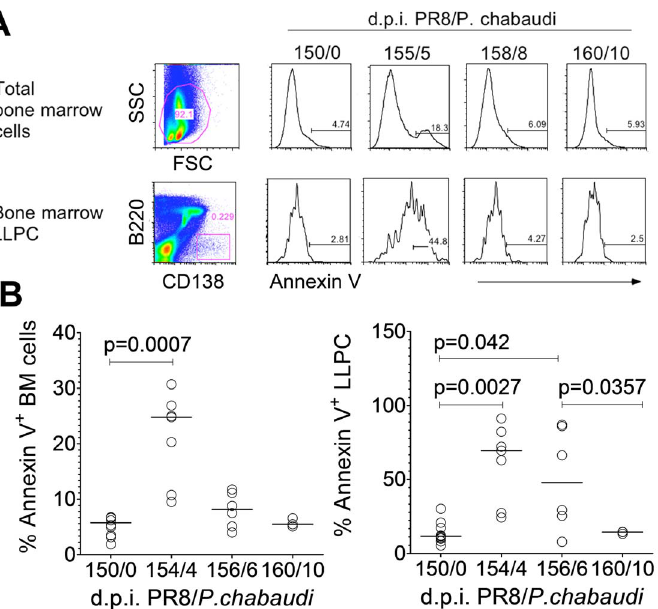
Figure 3. Long-lived plasma cells undergo apoptosis during acute P.chabaudi infection. A. Representative flow cytometry plots of total bone marrow cells and bone marrow LLPCs; and relative expression of Annexin V on days 0, 5, 8 and 10 of a P. chabaudi infection in BALB/c mice. B. Percentage Annexin V expression on total bone marrow cells and bone marrow LLPC on days 0, 4, 6 and 10 of P. chabaudi infection (n=10 (d0); 5 (d4); 6 (d6) and 3 (d10). Data were pooled from two independent